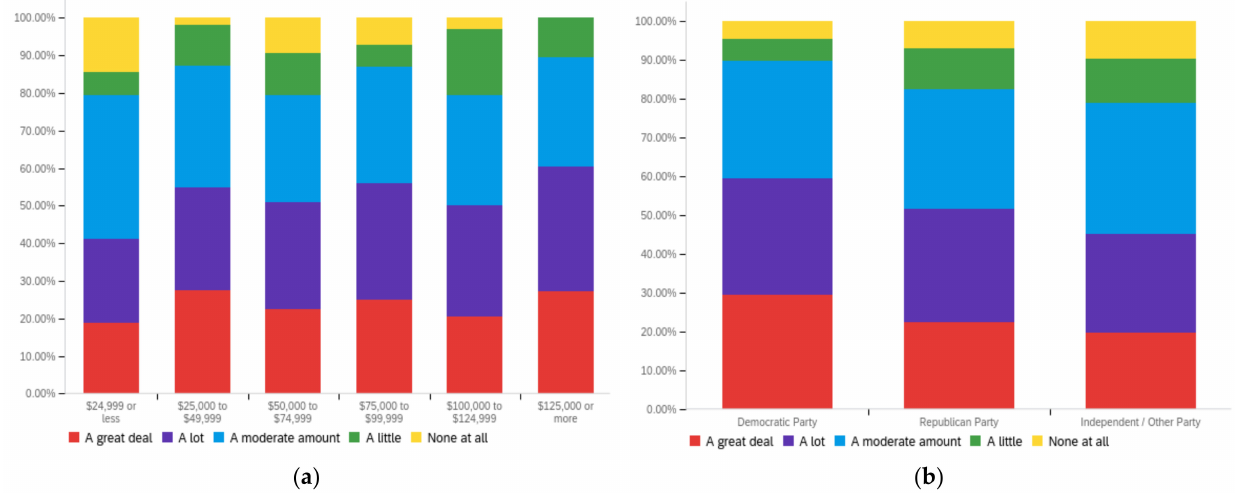
Figure A10. Cont